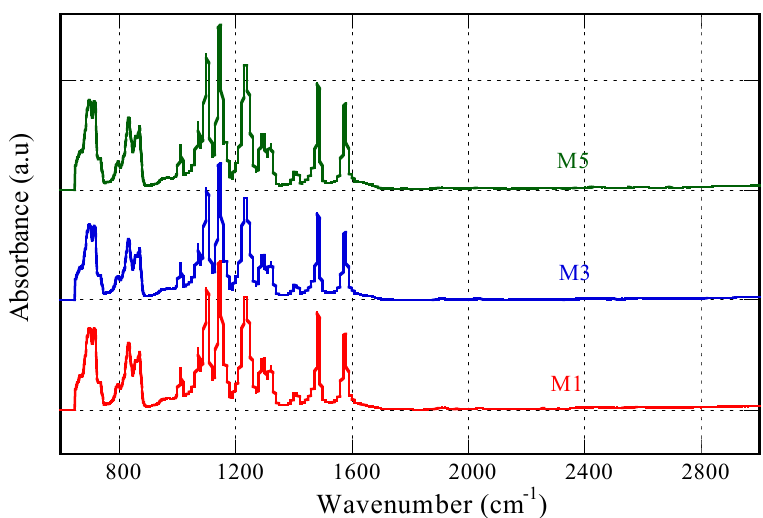
Figure 4. IR Spectrum of pure (M1) and silica modified PES membrane sourced from rice husk (M3) and sugarcane bagasse (M5).